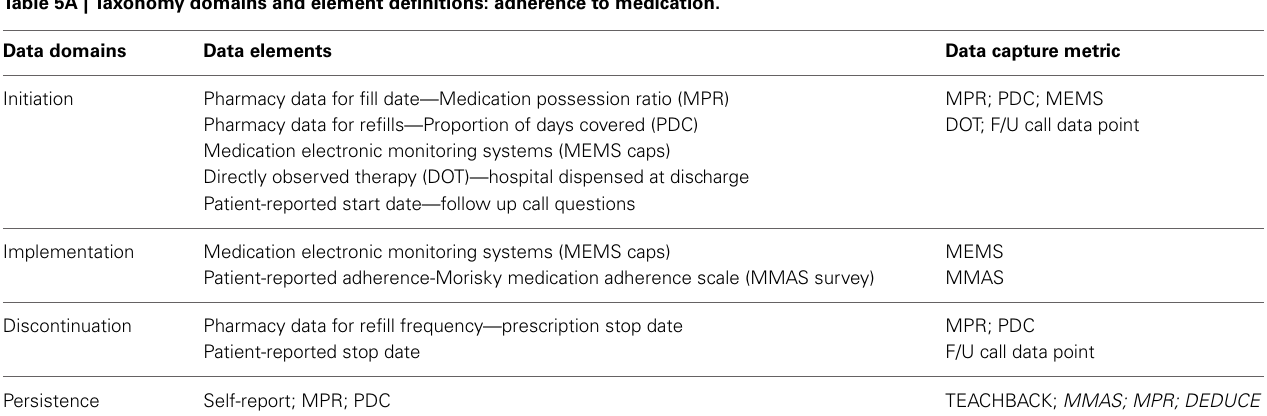
Table 5A | Taxonomy domains and element definitions: adherence to medication.